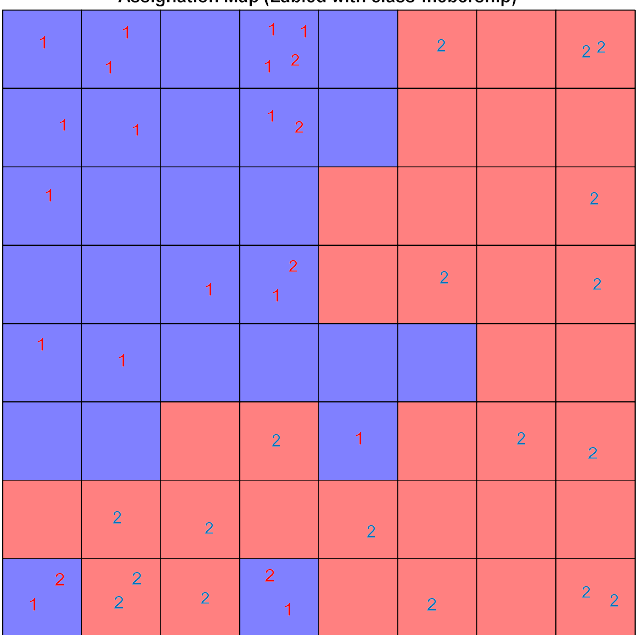
Figure 20. The Top-Map of SOM labeled with low (1) high (2) binding score.